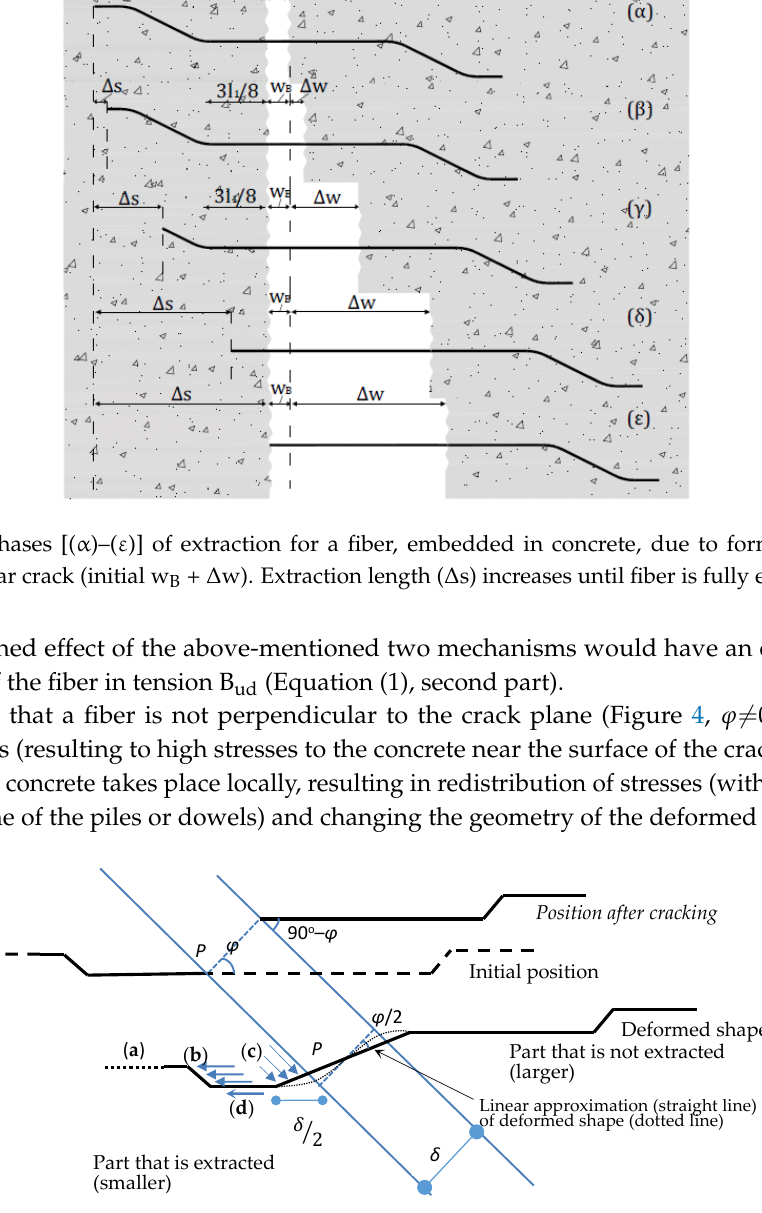
Figure 4. Modeled deformation of a single fiber crossing a crack ( ϕ is the inclination of the fiber from the perpendicular to the crack direction, and δ is the width of the crack). ( a )shortening of the smaller